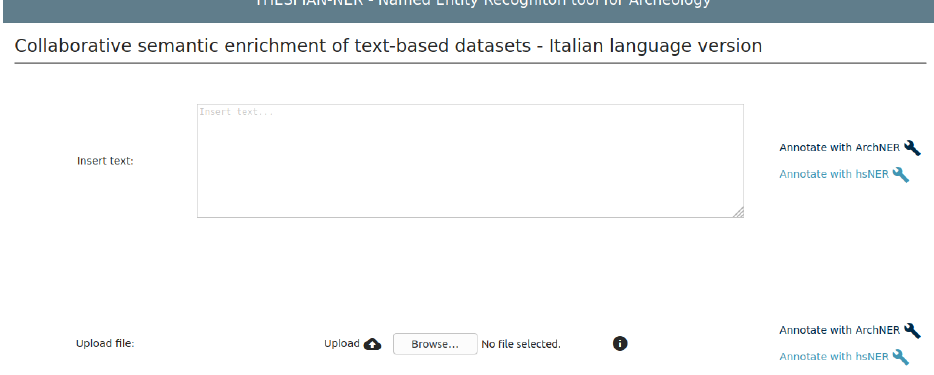
Figure 5. The NER web